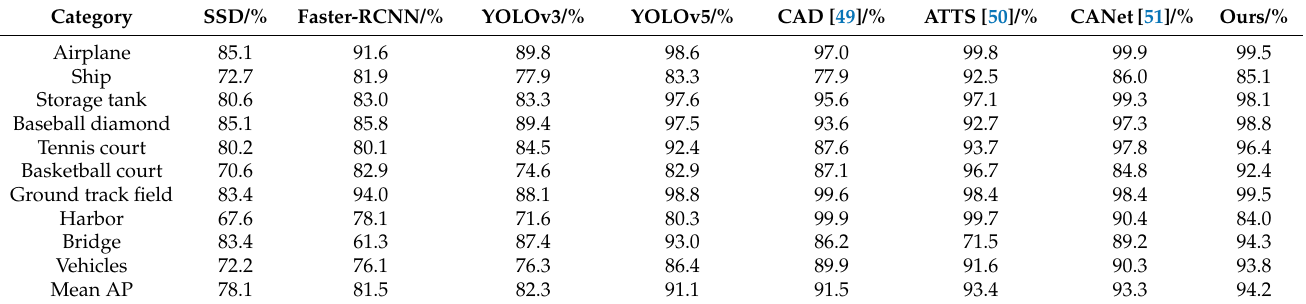
Table 10. Comparison of the KCFS-YOLOv5 with the common algorithms on the NWPU VHR-10